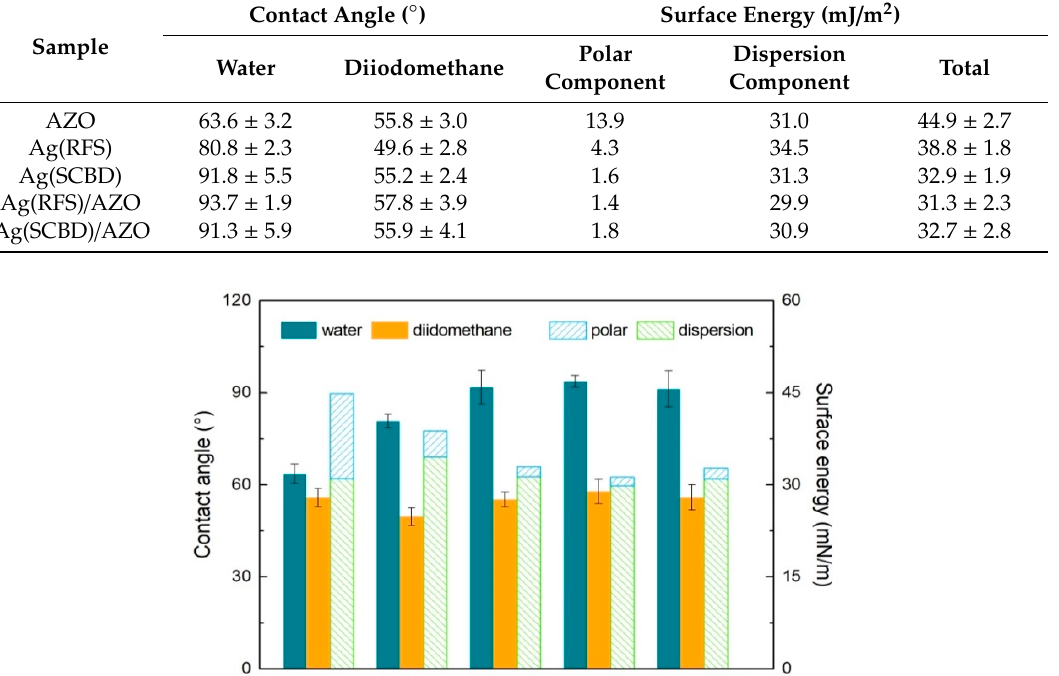
Figure 4. Contact angles (plain bars) and surface energy components (patterned bars) of samples deposited on PLA.